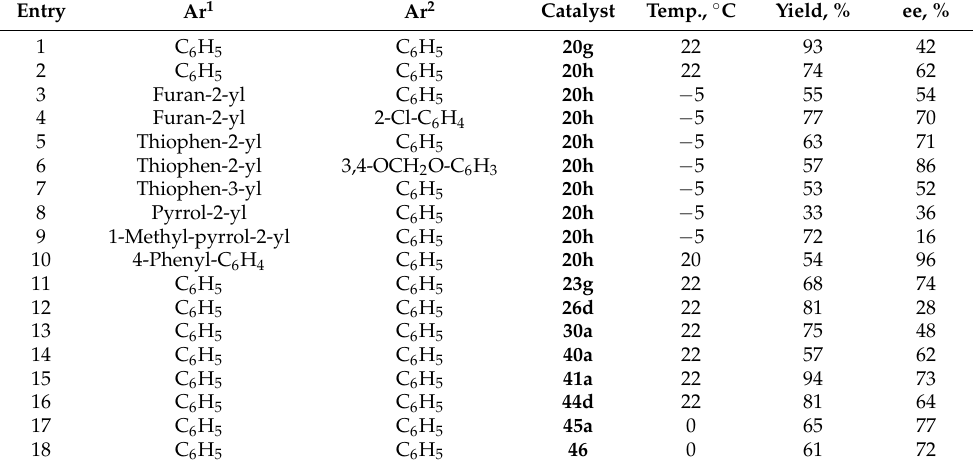
Table 11. Effect of crown ethers in the Darzens condensation of aromatic 2-chloroketones ( 78 ) and benzaldehydes ( 79 ).